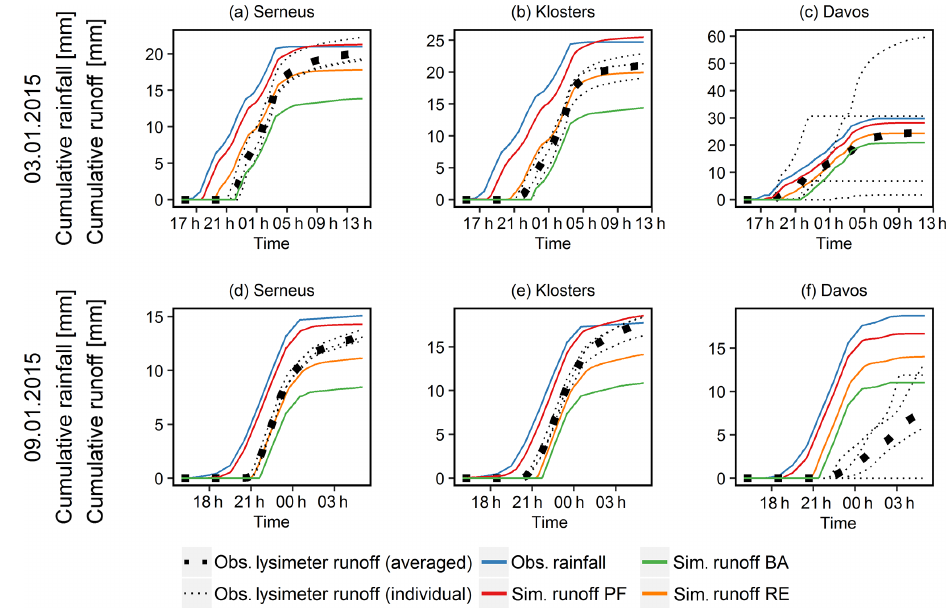
Figure 6. Natural ROS events on 3 and 9 January 2015 in (a, d) Serneus, (b, e) Klosters and (c, f) Davos. Table 2. Snowpack pre-conditions and R 2 for hourly snowpack runoff for natural events on 3 and 9 January. Site Pre-event snowpack R 2 for hourly conditions snowpack runoff HS LWC TS RE PF BA (cm) (% vol) ( ◦ C)